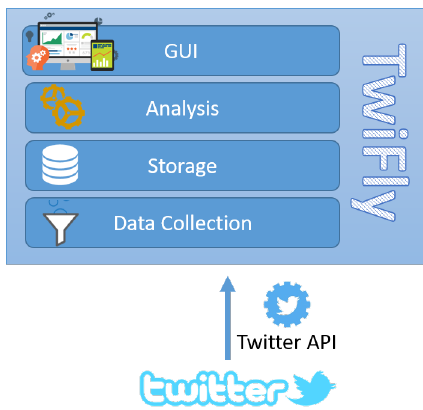
Figure 1. The high-level architecture of the implemented